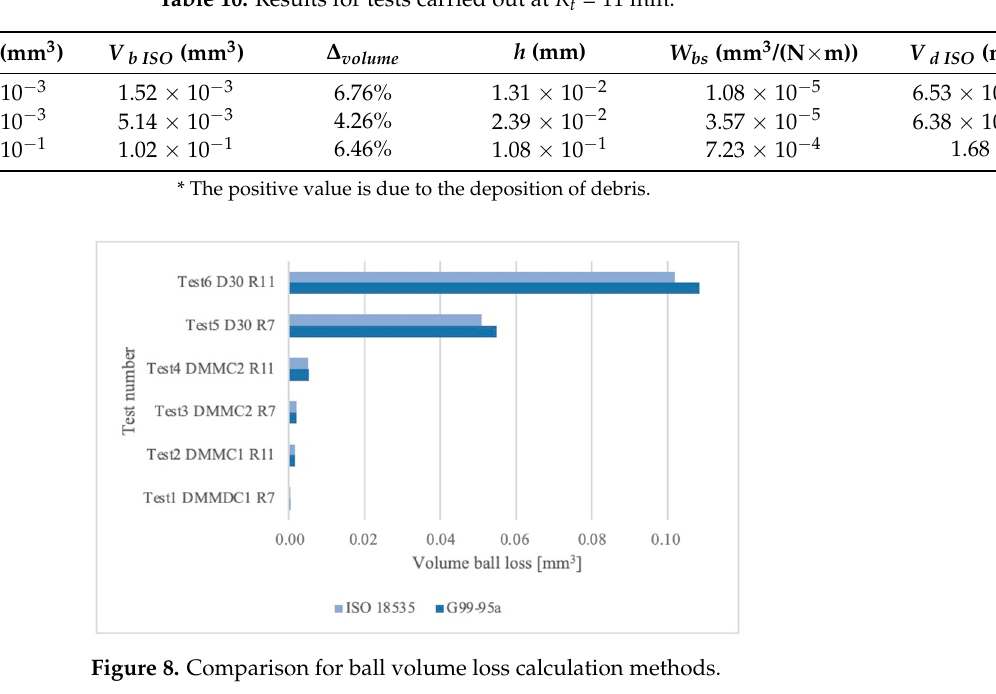
Table 10. Results for tests carried out at R t = 11 mm.